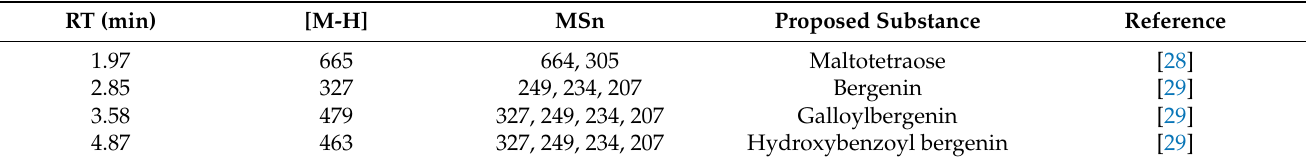
Table 2. Identification of the substances present in the ethyl acetate stem bar extract of Humiria balsamifera (Aubl).